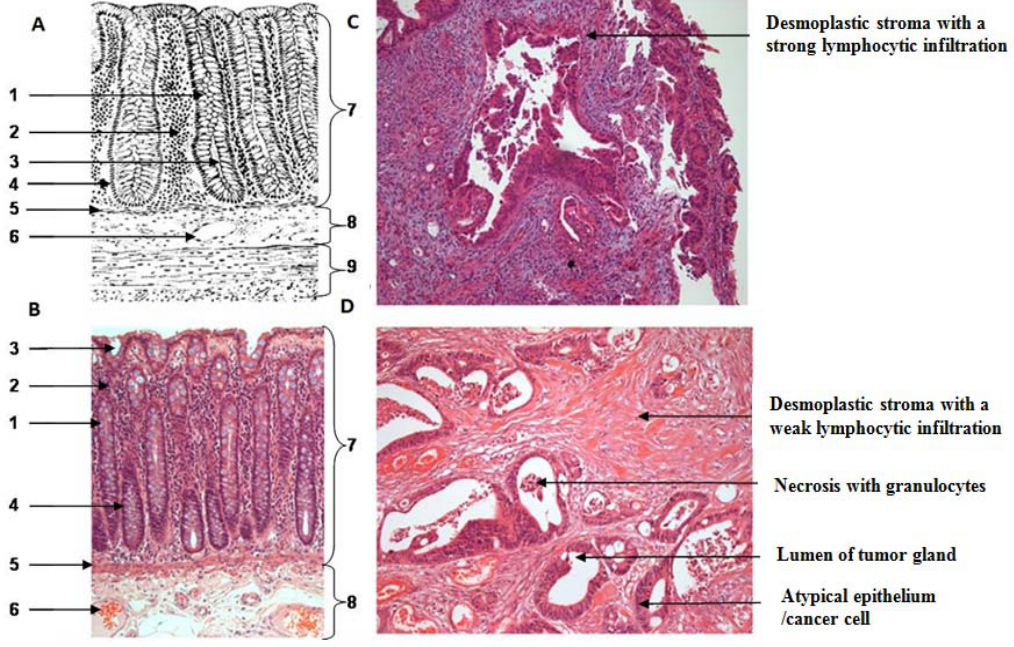
Figure 4. Hematoxylin and eosin (HE), ×10. Micrographic pictures of normal and tumor colonic tissue illustrating morphologic changes at stage of diagnosis and after neoadjuvant radiochemotherapy. ( A ) Normal structure of a non-tumoral colonic tissue, (Riemann et al . 2005), reflecting the typical components of the large intestinal wall of patient number 47 ( B ). (1) Goblet cells, (2) Lamina propia, (3) Crypt of Lieberkühn, (4) Paneth cells, (5) Muscularis mucosae, (6) Blood vessel, (7) Tunica mucosa, (8) Tunica submucosa, (9) Tunica muscularis externa; ( C ) Biopsy of an invasive moderate-grade colorectal adenocarcinoma at stage of diagnosis of patient no. 93. Desmoplastic and cytoplastic effects with partly retained glandular-like structures and a high density of hyperchromatic cells infiltrating the submucosa; ( D ) Resected tumor material of an invasive moderate-grade colorectal adenocarcinoma after neoadjuvant radiochemotherapy of patient no. 93. Scarred fibrotic components with atypical epithelium, desmoplasia and weak lymphocytic